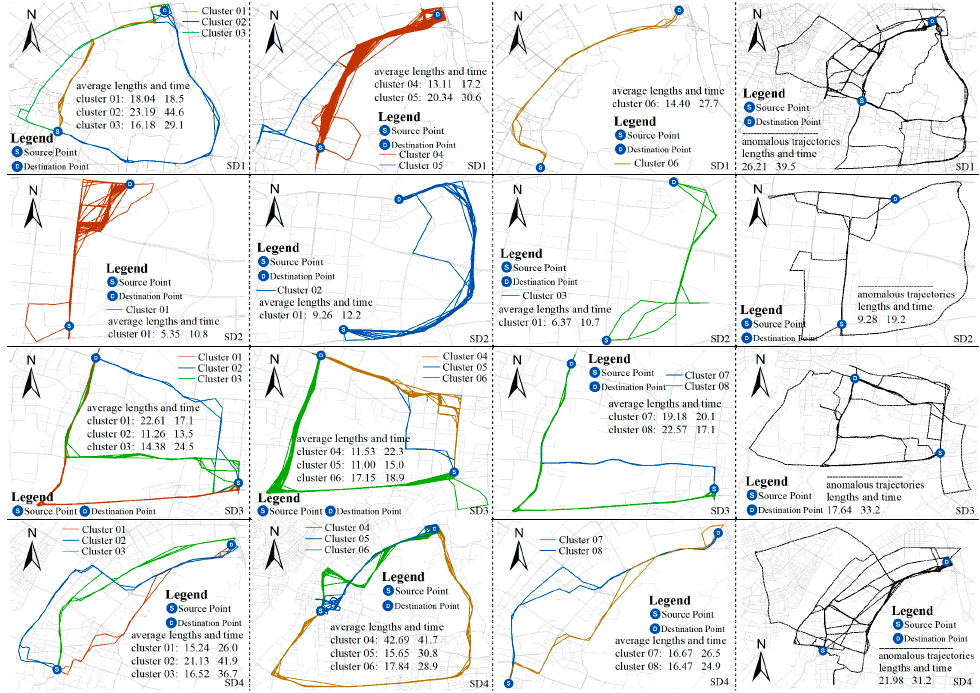
Figure 6. Geographic distribution of clustering results in SD1–SD4 pairs of experimental data.